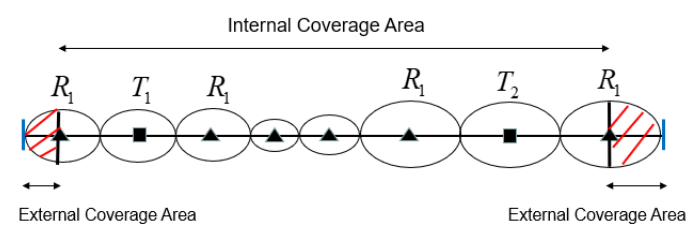
Figure 4. Internal and external coverage area on a BR sensor barrier.